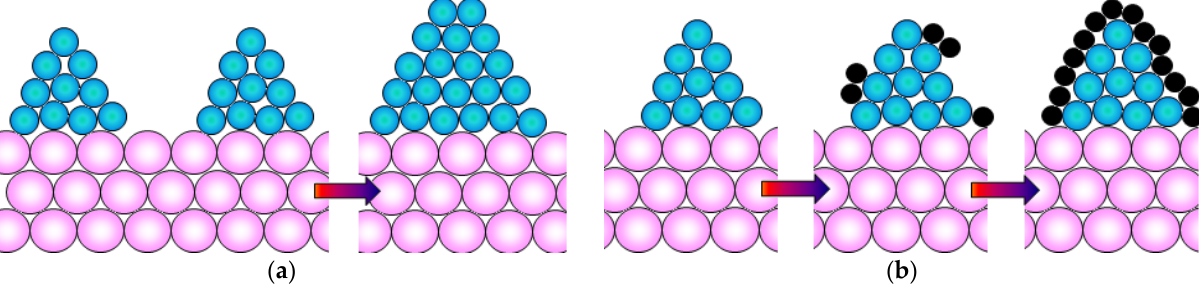
Figure 3. Schematic illustrations of the sintering ( a ) and coking ( b ) processes for SRM catalyst. Pink, blue and black balls denote support, metal catalyst and carbon, respectively.